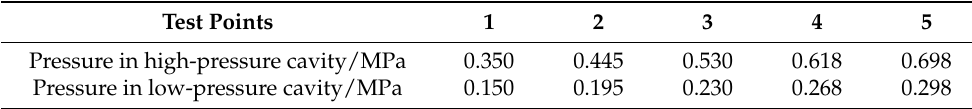
Table 2. Experimental